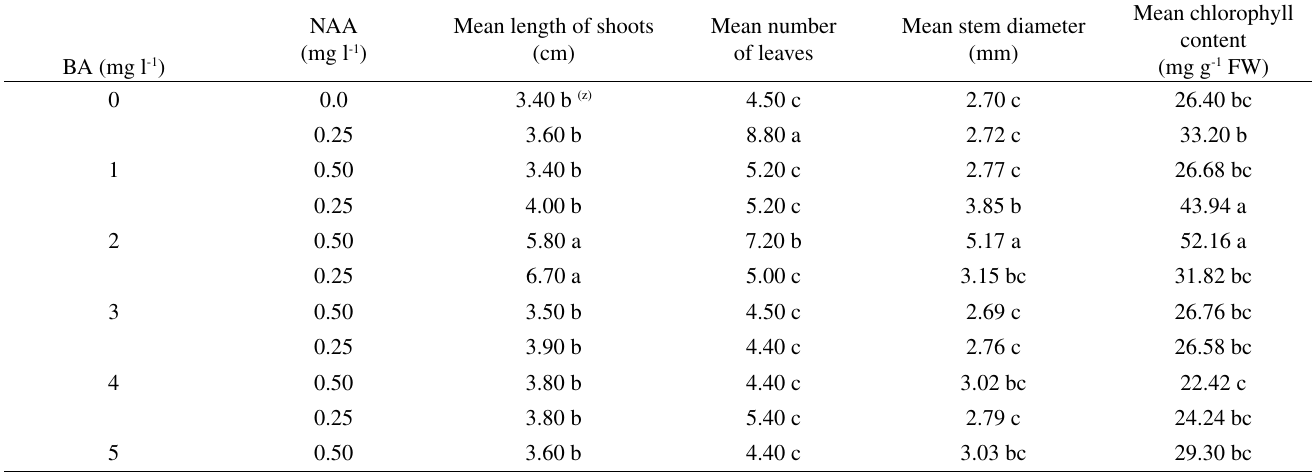
Table 3 - Effects of different treatments on some characteristics of acclimatized ‘Green’ plantlets, 60 days after transfer